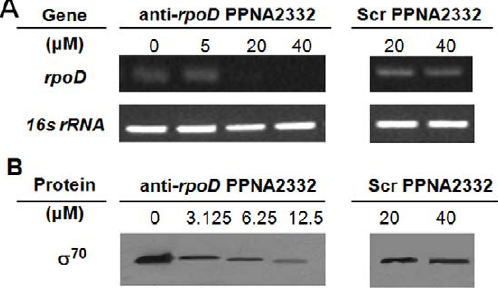
Figure 4. Specific inhibition of RNAP primary s 70 gene transcript and protein expression by anti- rpoD PPNA 2332. Triplicate bacterial cultures were grown for 18 h in 100 m L of MH broth in the presence of anti- rpoD PPNA2332 and scrambled PPNA2332 at different concentrations with MRSA/VISA Mu50 cells, respectively. The anti- rpoD PPNA2332 was added once at the start of the growth period. After 18 h of growth, total RNA and protein was isolated from treated and untreated cultures. (A) Cellular levels of s 70 RNA were determined by RT-PCR. The reduction in the amount of RT-PCR product corresponding to gene rpoD in cells treated with anti- rpoD PPNA2332 at different concentrations was determined as the product specific for rpoD RNA relative to products for 16S rRNA . (B) Expressions of s 70 protein in different treatment were analyzed by western blotting and were quantitated